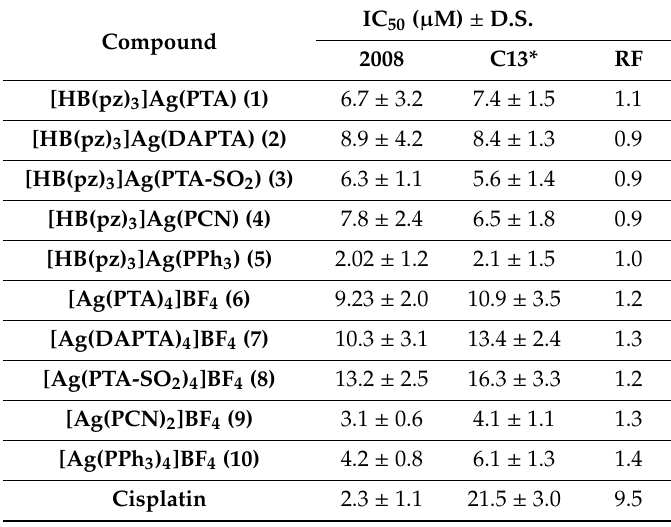
Table 3. Cross-resistance profiles. Cells (3 × 10 3 · mL − 1 ) were treated for 72 h with increasing concentrations of tested compounds. Cytotoxicity was assessed by MTT test. IC 50 values were calculated by a